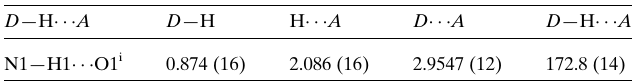
Table 2 Hydrogen-bond geometry (A˚ , (cid:3) ) for (I).